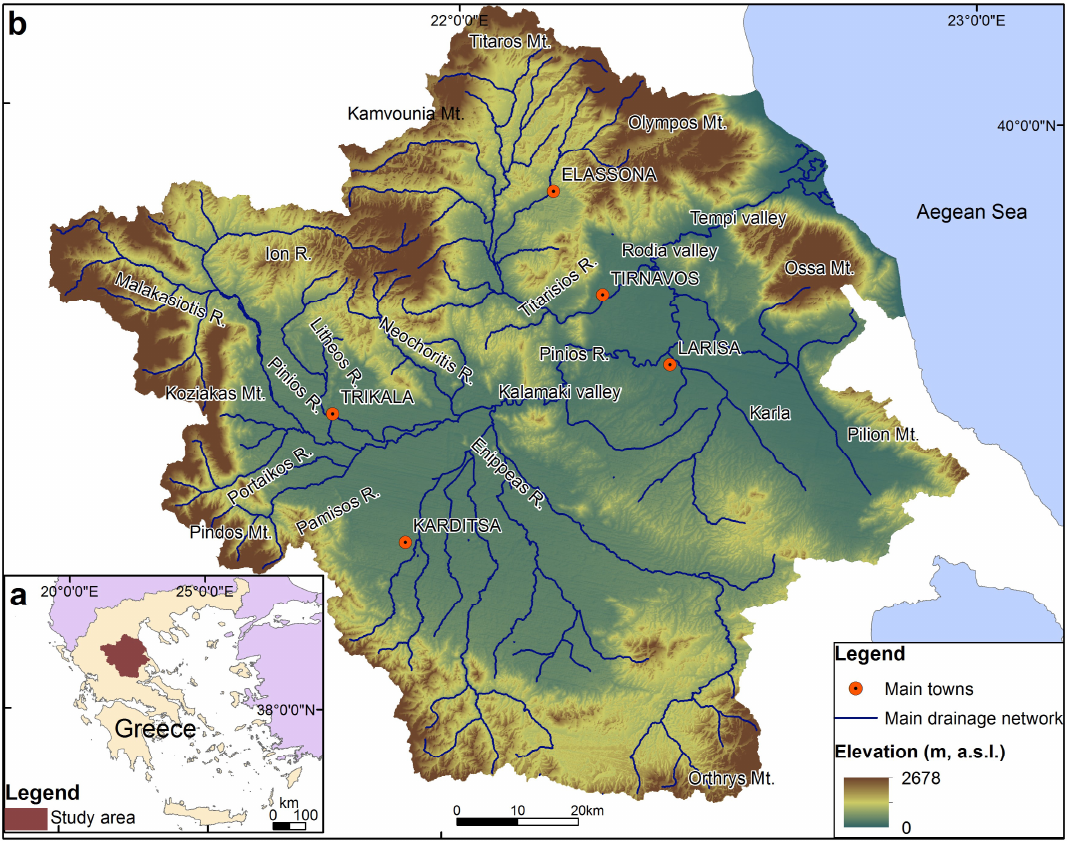
Figure 1. ( a ) Location map of the study area; ( b ) the elevations of the study area, the drainage network, the road network and the main settlements (modified from